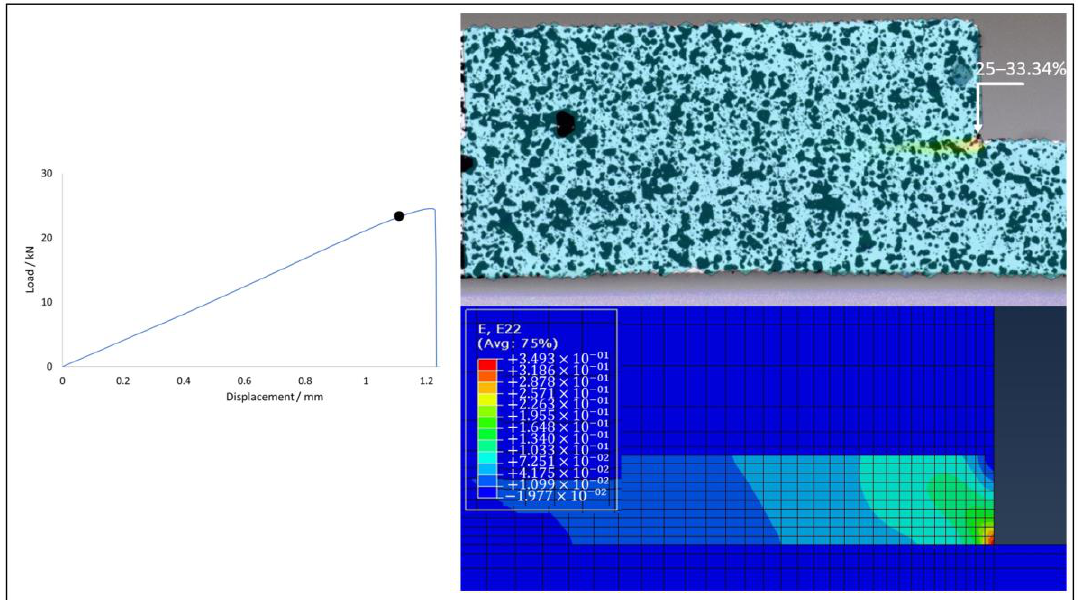
Figure 13. Strain field in Al-CFRP-Al joint: DIC (top) vs. numerical (bottom).